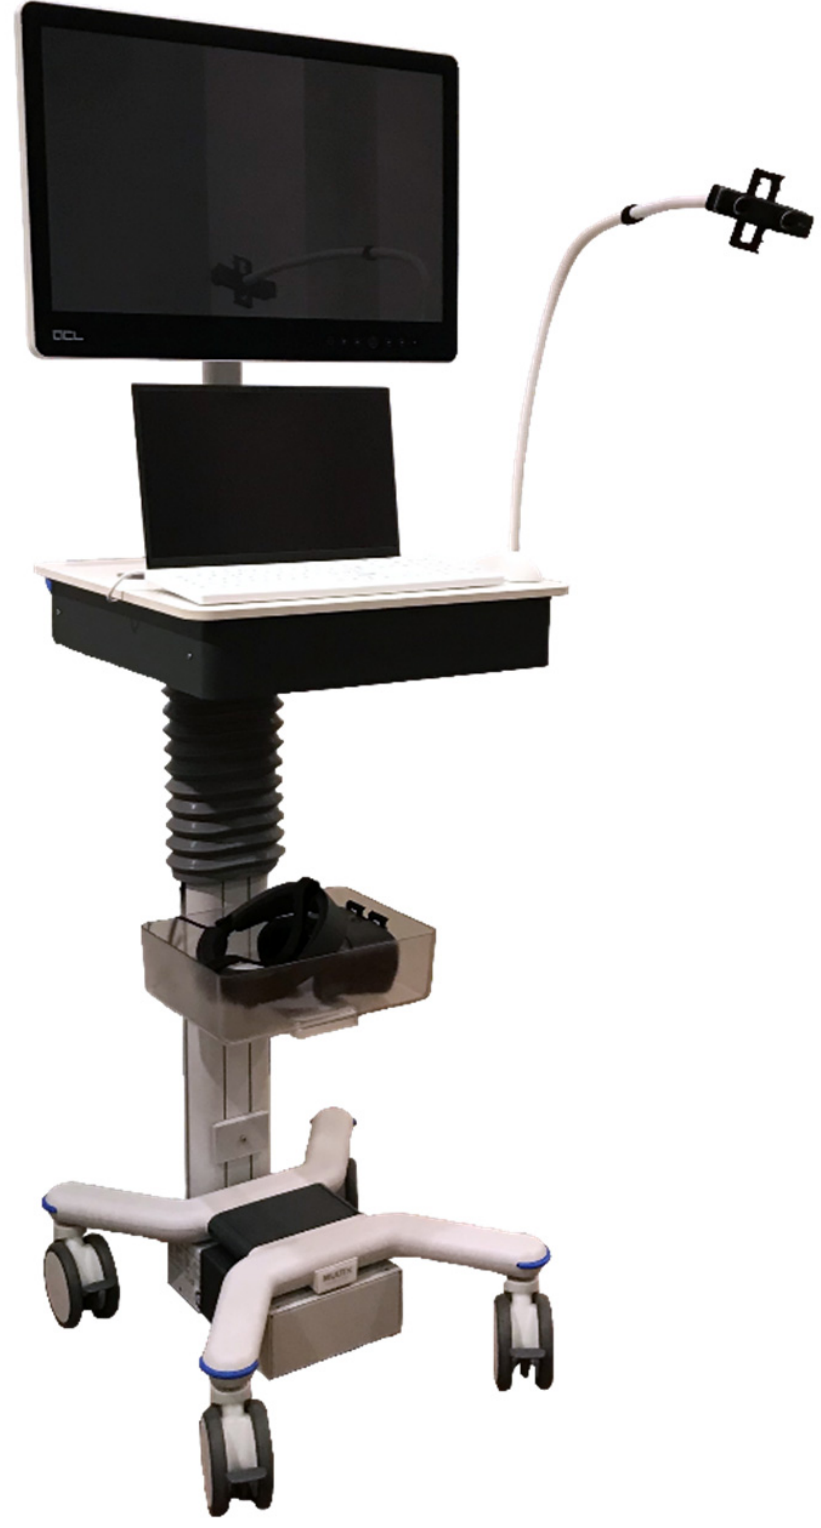
Figure 2. Endosight system overview: cart, medical display, laptop, and Oculus Rift-S paired with a Zed Mini camera.